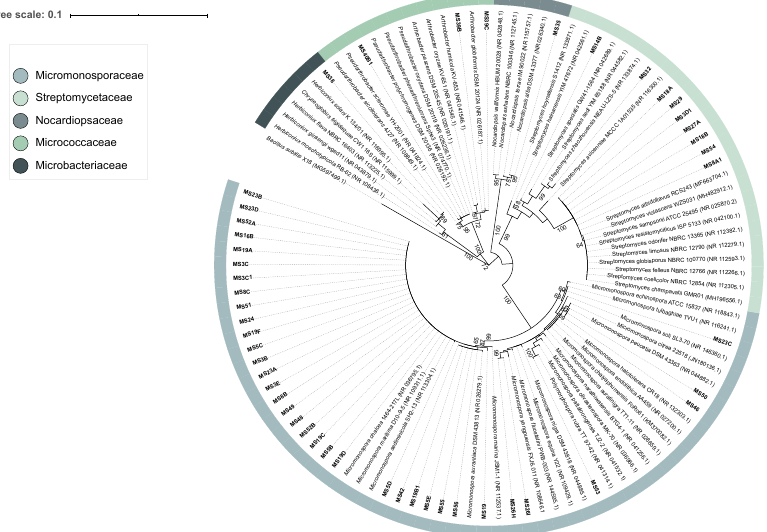
Figure 2. Phylogenetic tree of the Actinobacteria strains isolated from coastal marine sediment and their GenBank nearest neighbours. Maximum likelihood phylogenetic tree was performed in MEGA 7 using 107 sequences with 1090 bp. The phylogeny test used was the bootstrap method with 1000 replications. Bootstrap values shown at nodes support the branching order of the tree (values below 60% are not shown). The GenBank accession numbers are indicated in parenthesis. Bacillus subtilis X-18 was used as an outgroup. Scale bar corresponds to 0.1 substitutions per nucleotide position. The sequences of strains MS40A and MS58, assigned to the family Thermomonosporaceae, were not included in the tree as their length was < 900